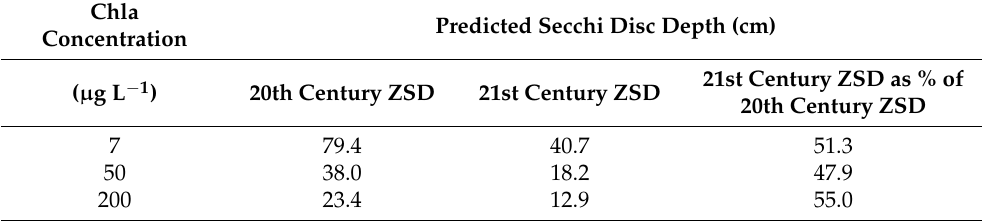
after (21st century) the adoption of GR